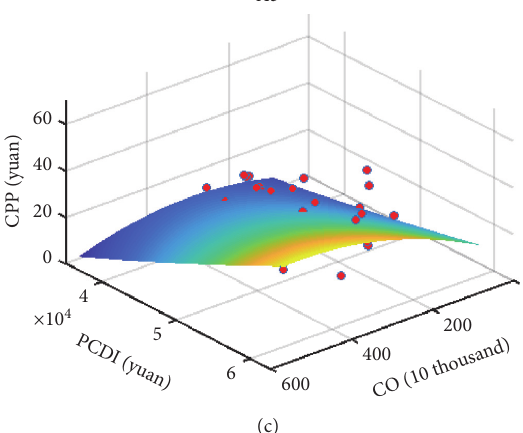
Figure 1: 3D data visualization for rich cities: (a) the effect among CPP-UD-CO, (b) the effect among CPP-UD-PCDI, and (c) the effect among CPP-CO-PCDI.